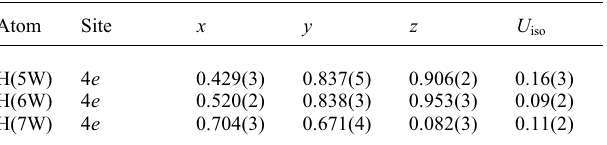
Table 3. Atomic coordinates and displacement parameters (in Å 2 )